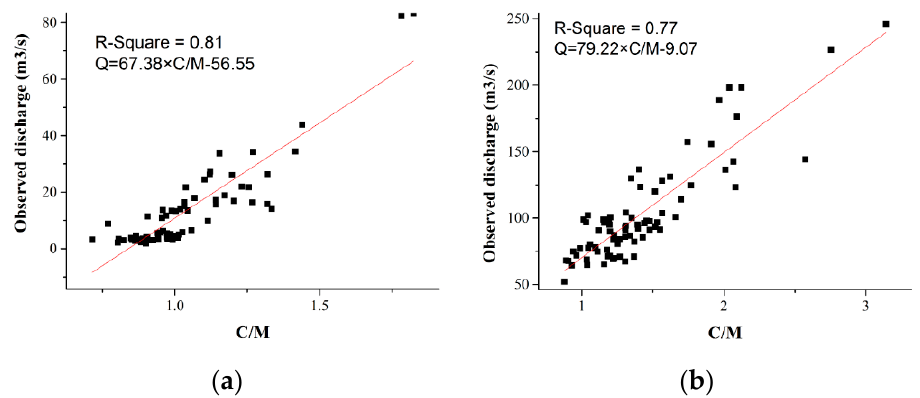
Figure 5. Correlation and scatter plot of the C/M ratio and observed discharge. ( a ) Gauge 410130, ( b ) Gauge 414200 (Q refers to estimated discharge based on the C/M method).